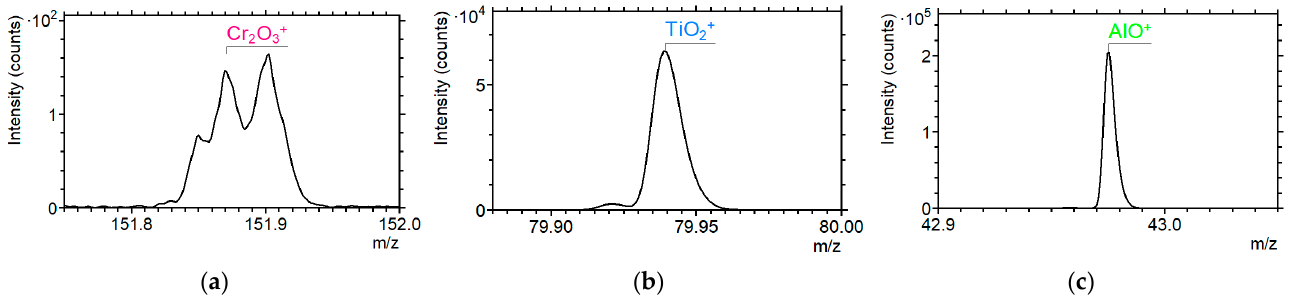
Figure 2. Mass spectra of secondary Cr 2 O 3+ ( a ), TiO 2+ ( b ), and AlO + ( c ) ions from the TiAlCrSiYN/TiAlCrN coating after annealing in an open furnace for 45 min at 700 °C, obtained at different depths from the surface during ion etching.